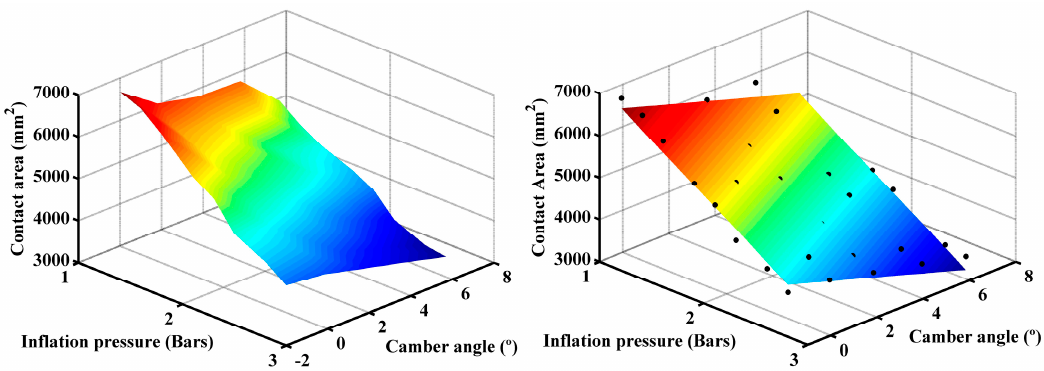
Figure 15. Contact area vs. camber angle and tire inflation pressure: measured data ( left ); and fitted data ( right ).